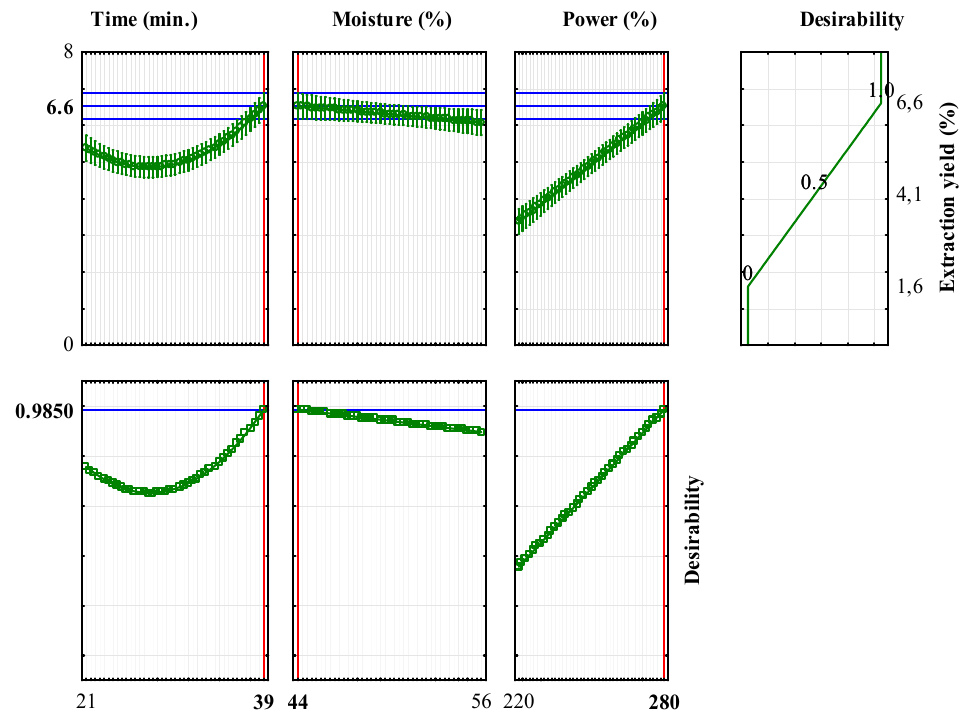
Figure 2. Profiles of predicted response values and desirability function. The red lines indicate experimental values after optimisation.